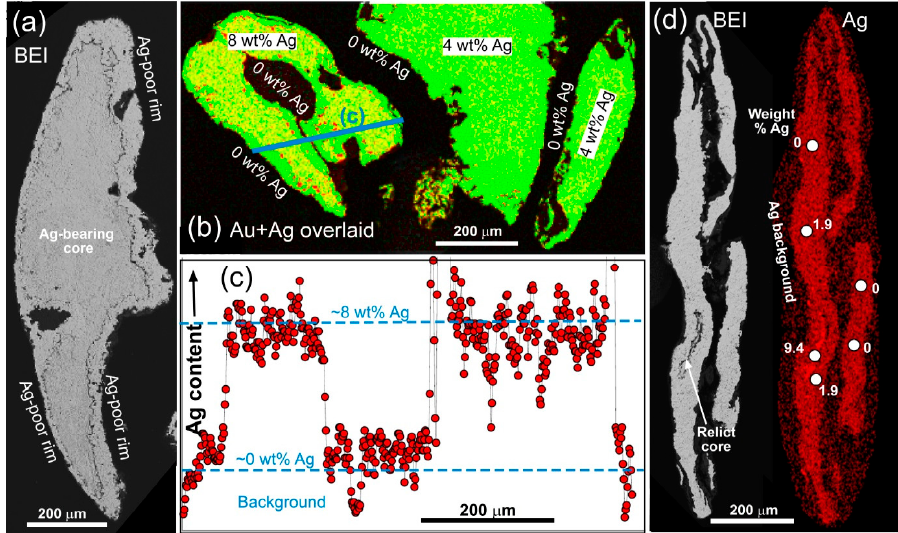
Figure 5. SEM images and EDS analytical data for gold particles from the August 2017 sample at the Waikaia placer mine. ( a ) Backscatter electron image showing the textural contrast between the core and rim of a moderately flattened particle; ( b ) Overlaid Au and Ag EDS maps, showing the contrasting Ag contents of adjacent particles; ( c ) Ag transect across a folded gold particle (indicated in ( b ), with recorded spot data (red circles; 3 s counts) and lines linking a running average; ( d ) Backscatter electron image and Ag map, with point Ag analyses, of a flattened and folded particle.